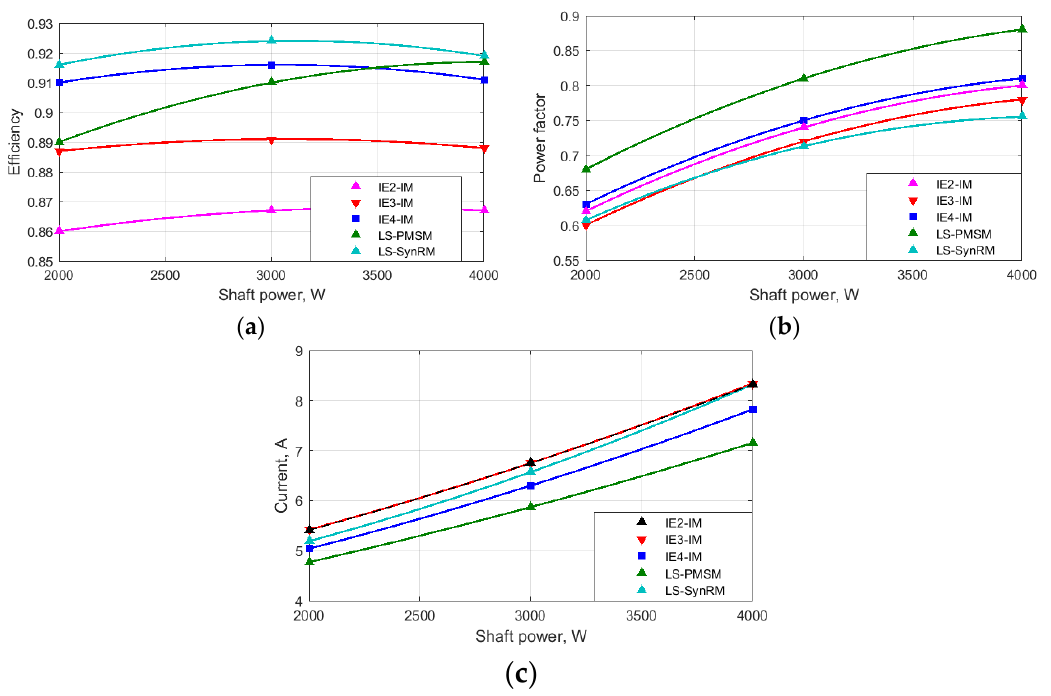
Figure 3. Motor characteristics vs. motor shaft power: ( a ) efficiency; ( b ) power factor; ( c ) current.